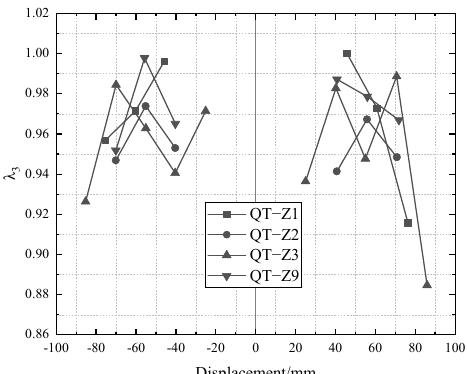
Figure 21. Degradation coefficient λ 3.